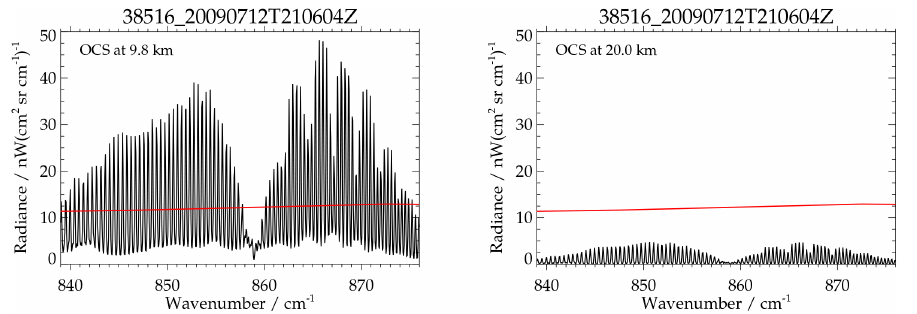
Figure 1. Left: spectral OCS signature for a measurement on 12 July 2009 at southern mid-latitudes (42.8 ◦ S, 18.7 ◦ E) at 9.8km tangent height, expressed as difference between the model spectrum resulting from the OCS fit and a spectrum for the same atmosphere without OCS. Right: same as left, but for 20.0km altitude. Red curves indicate the noise-equivalent spectral radiance